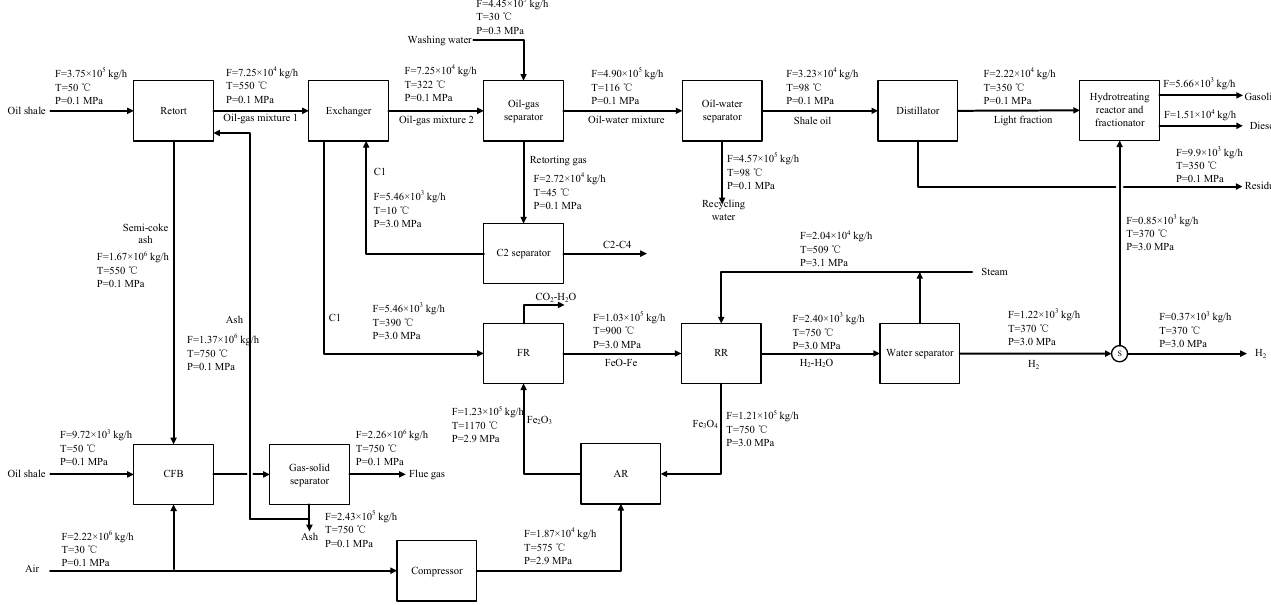
Figure 12. Material flow of the CLeSTL process (oil light fraction hydrogenation).